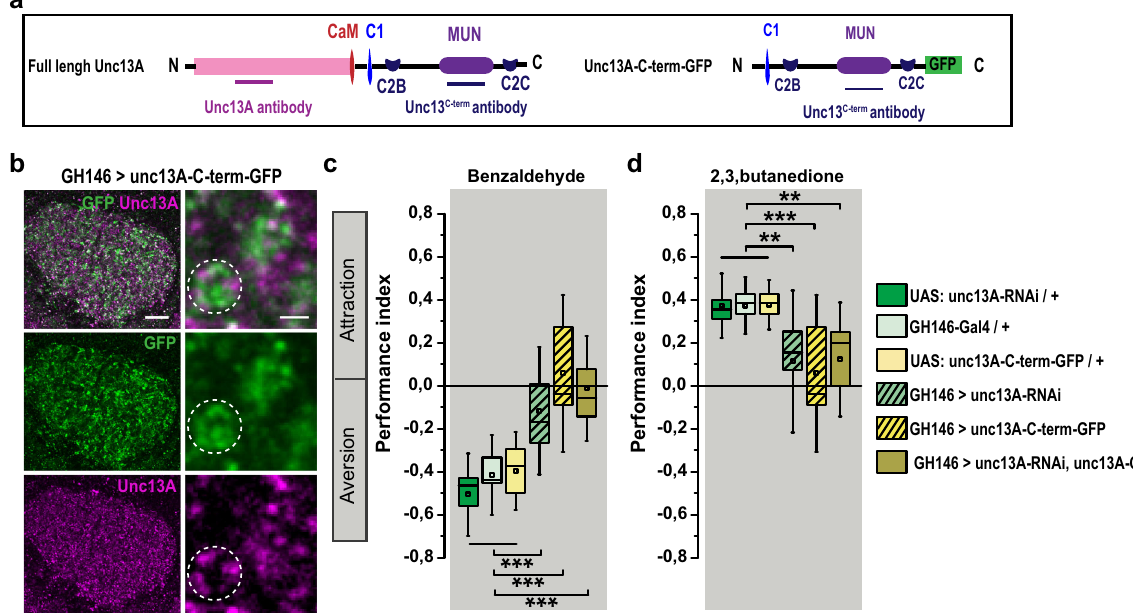
Fig. 5 Olfactory impairment in animals overexpressing unc13A-C-term-GFP in ePNs. a Schematics of full-length Unc13A and Unc13A-C-term-GFP constructs indicating CaM, calmodulin; C1, C2B, C2C, and the MUN domain. b Confocal images from the calyx region in animals expressing UAS: unc13A -C- term-GFP in ePNs under control of GH146-Gal4, immunostained against Unc13A (magenta) and GFP (green) Scale bars: 10 μ m, in inset: 500 nm. The white circles indicate the localization of C-term-GFP fragment (green) between endogenous Unc13A clusters ( n = 4, experiment was performed once). c , d Performance index of animals with unc13A knockdown in ePNs, overexpression of unc13A -C-term-GFP in ePNs or both show signi fi cant reduction toward aversive ( c ) and appetitive ( d ) odors compared with their genetic controls ( n = 12 – 14). All p values were calculated via one-way ANOVA with the Bonferroni multiple comparison post hoc test (** p ≤ 0.01, *** p ≤ 0.001). Box plots indicate means (black squares), medians (middle lines), 25th and 75th percentile ranges (boxes), and SD ranges (whiskers). Source data including the exact sample sizes and the p values are provided as a Source Data fi